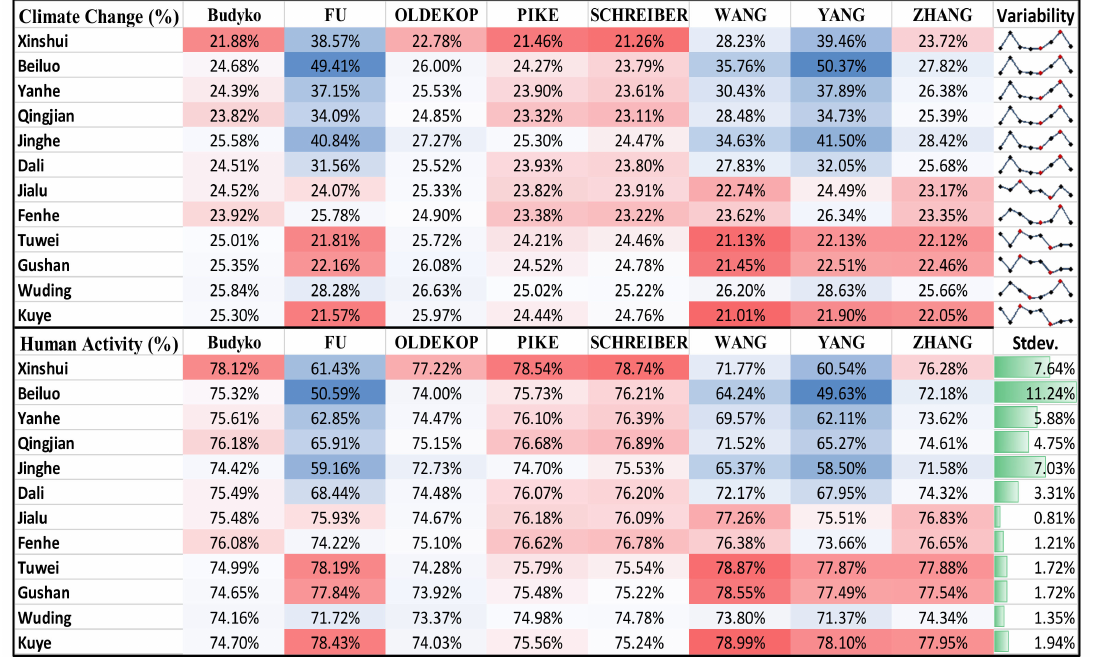
Figure 3. Quantitative contribution to streamflow change by climate change (%) and human activities (%): for each type of eight Budyko-based methods, contribution values are averaged over results calculated with 13 E 0 estimations; at the catchment scale, the variability (line plot) and standard deviation (bar plot) of contribution values derived by different methods are also shown